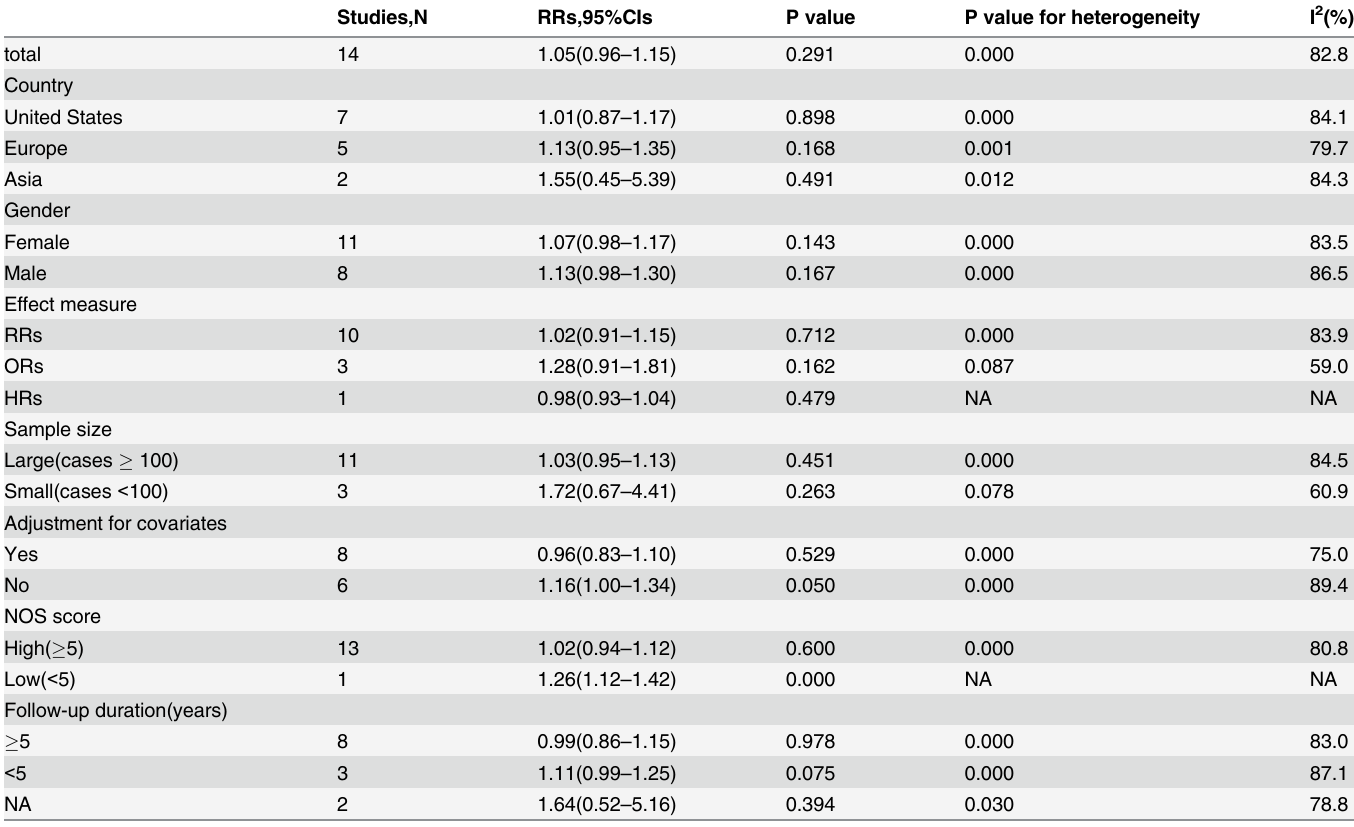
Table 4. Sensitive analyses based on various exclusion